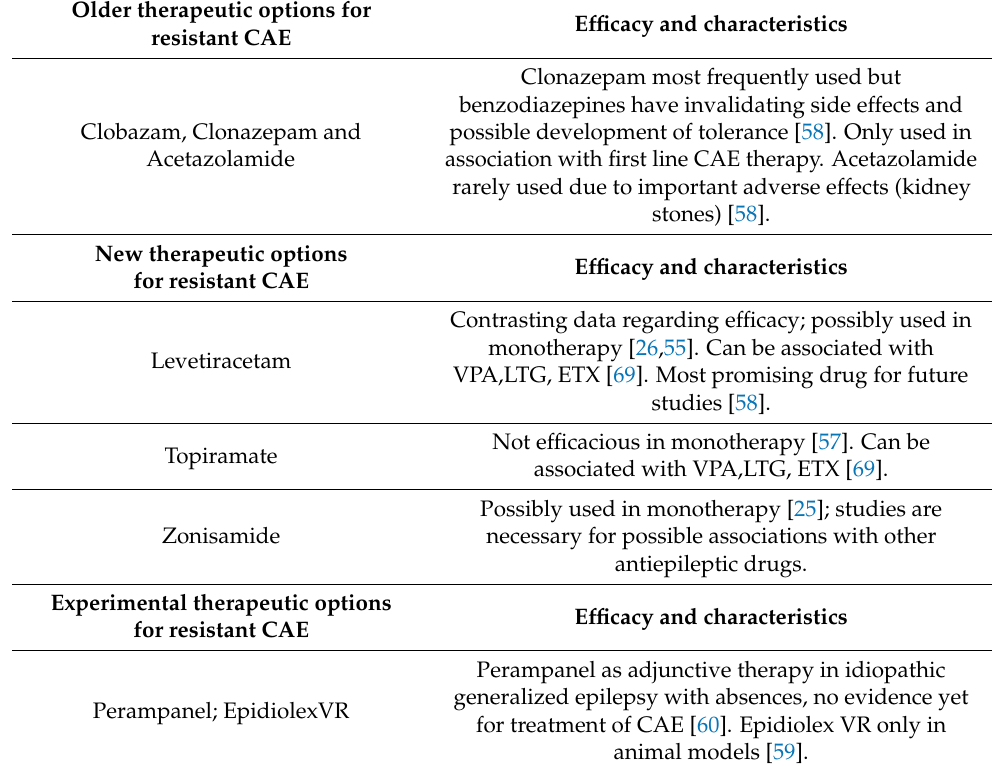
Table 1. Possible therapeutic options for first line therapy-resistant CAE